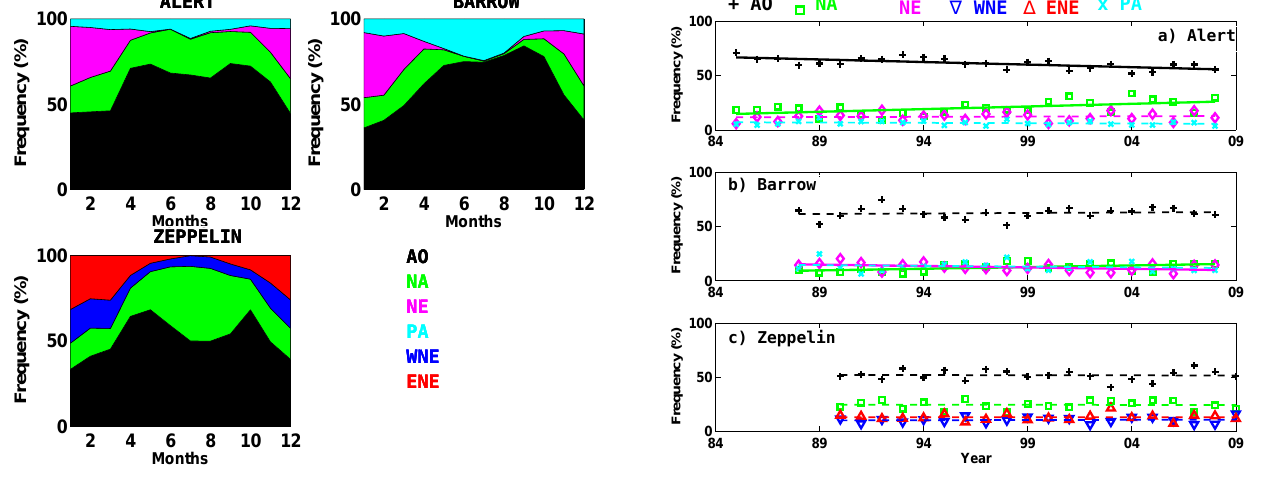
Fig. 11. Annual mean cluster frequency as a function of time at Alert (a) , Barrow (b) , and Zeppelin (c) . The colour codes are indi- cated at the top. Linear trends are also shown, as solid lines when statistically significant with a minimum confidence of 90% and as dashed lines when the confidence is